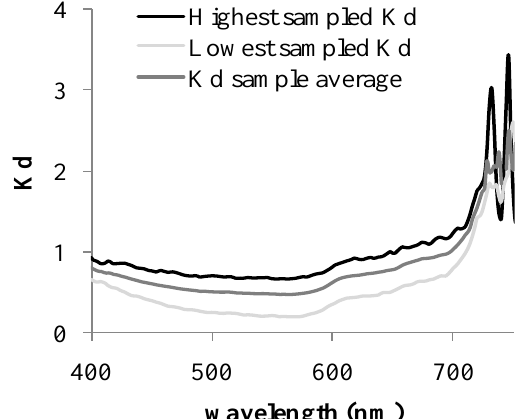
Figure 2. Downwelling diffuse attenuation coefficients, K time of in situ spectra and image